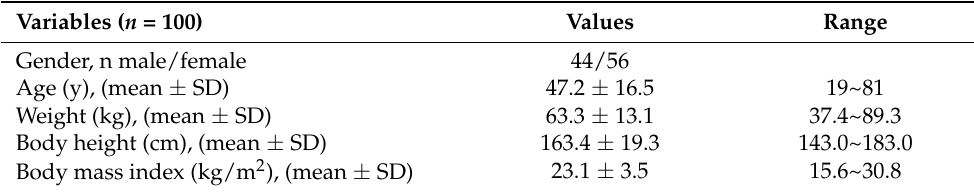
Table 1. Demographic characteristics of